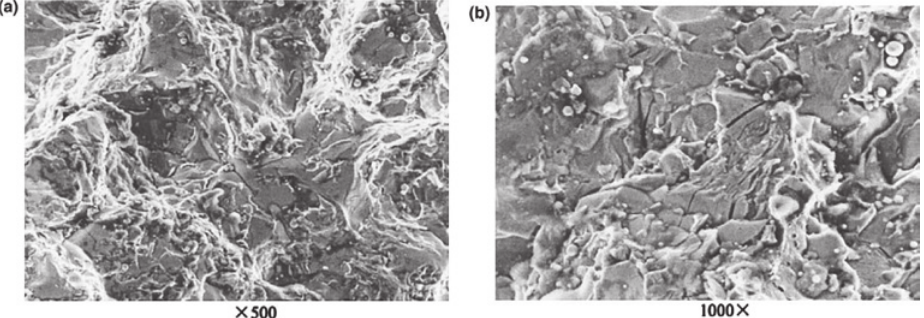
Fig. 10: Scanning electron fracture micrographs, with tensile tested specimens at different magnifications